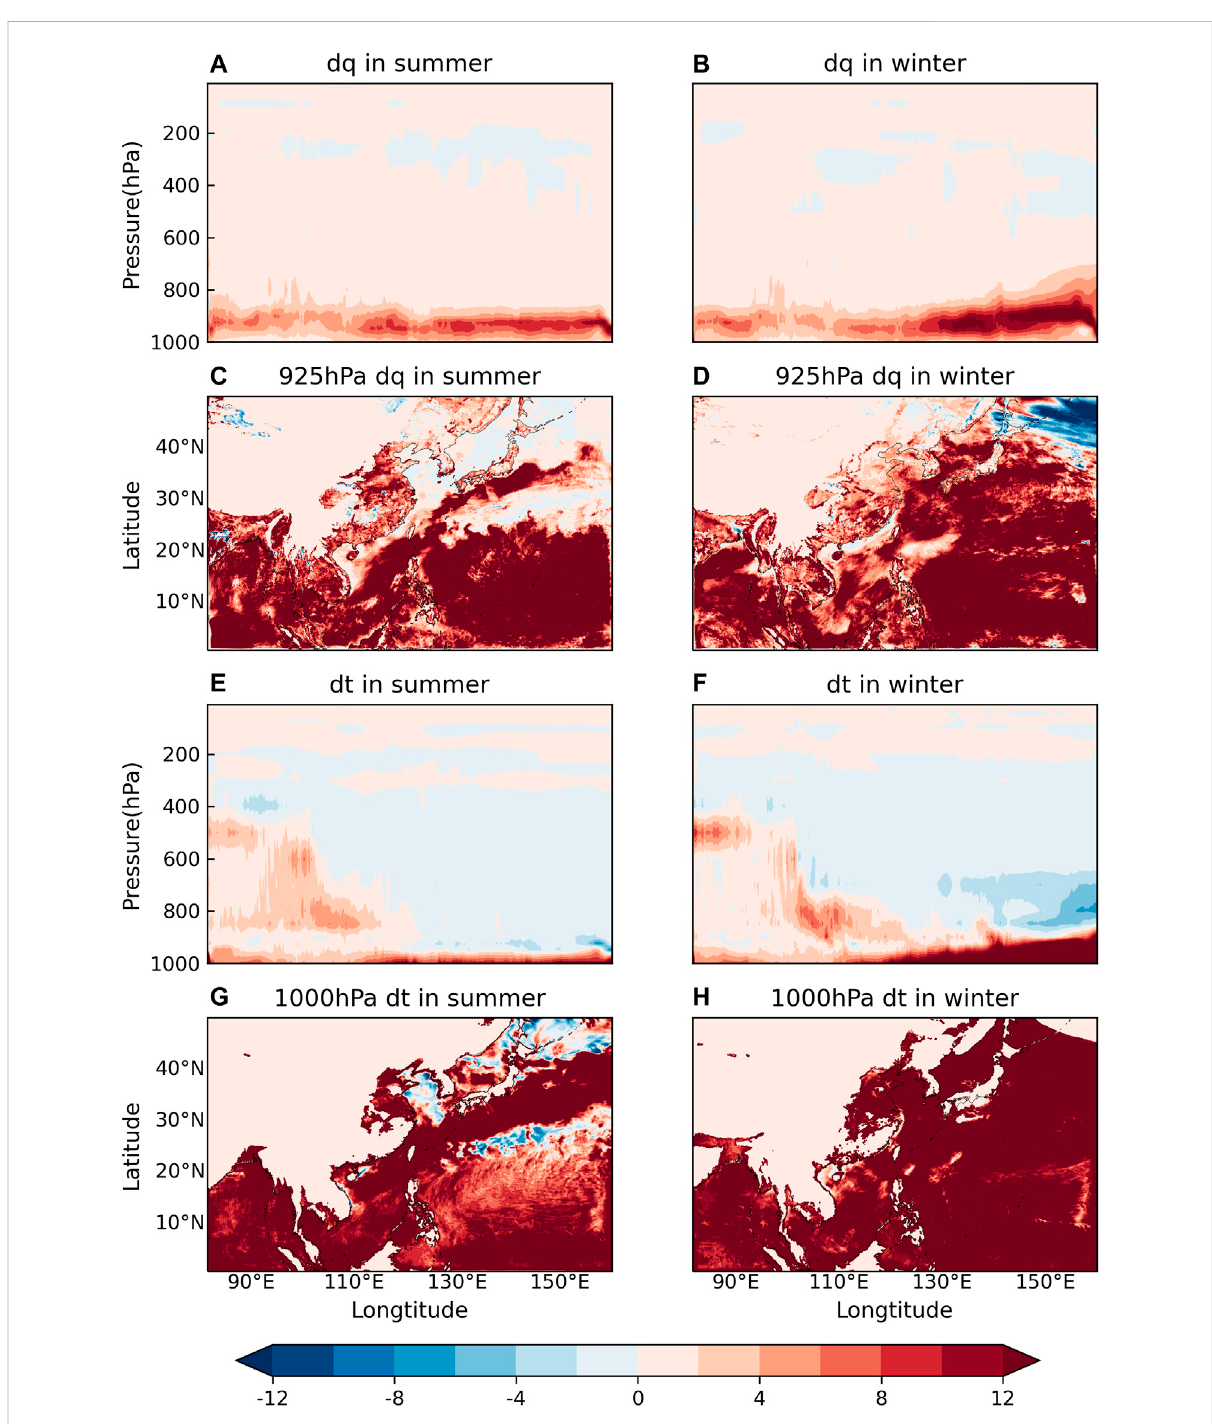
FIGURE 5 Vapour and temperature tendencies of the boundary layer process. (A – D) Vapour tendency (10 – 3 g/kg). (E – H) Temperature tendency ( ° C). (A,E) Latitudinalaveragecross-sectioninthesummer. (B,F) Latitudinalaveragecross-sectioninthewinter. (C) 925 hPainthesummer. (D) 925 hPain the winter. (G) 1000 hPa in the summer. (H) 1000 hPa in the